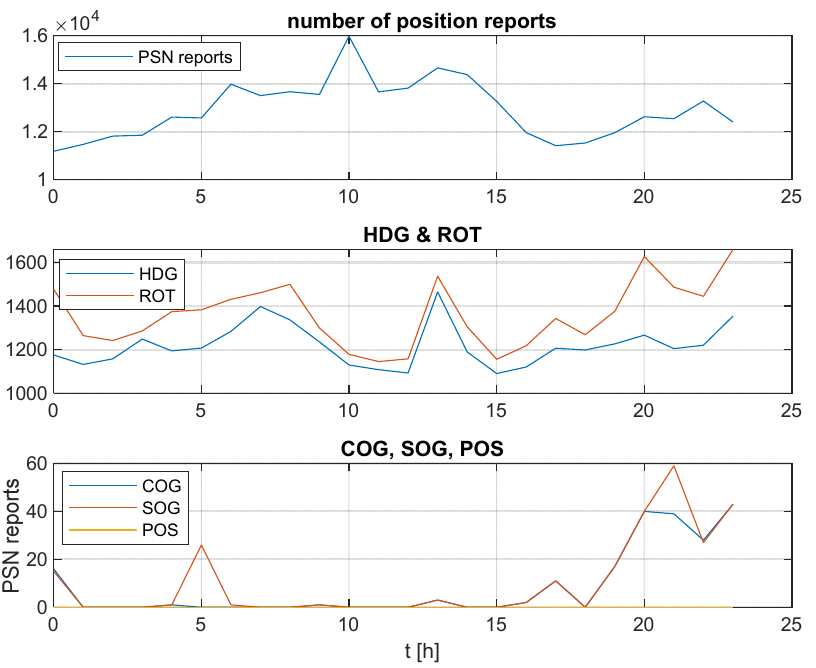
Figure 2. A graphic presentation of incomplete dynamic data of the AIS service with a one-hour interval, and a record of twenty-four hours of an AIS receiver operation [prepared by the author].